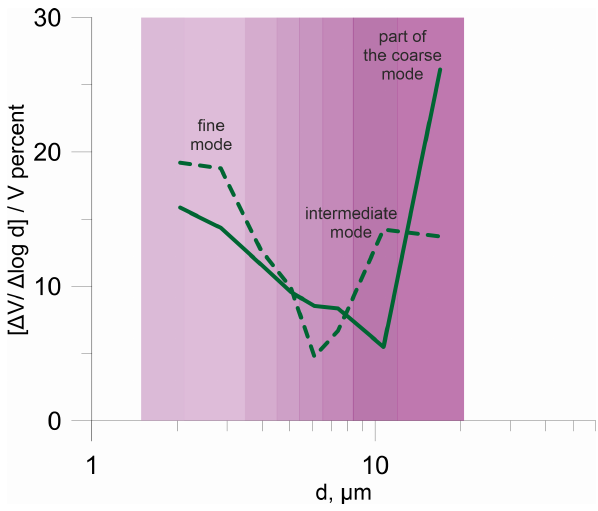
Figure 9. The typical examples of the bimodal volume–size SPM distribution. The x axis is particle diameter; the y axis is proba- bility density function. Green solid line – dominance of aggregates (station AI-903, 3678m); dashed green line – intermediate mode, caused mostly by phytoplankton, detritus and transparent exopoly- mer particles (station AI-887, 3717m). Size intervals are marked with